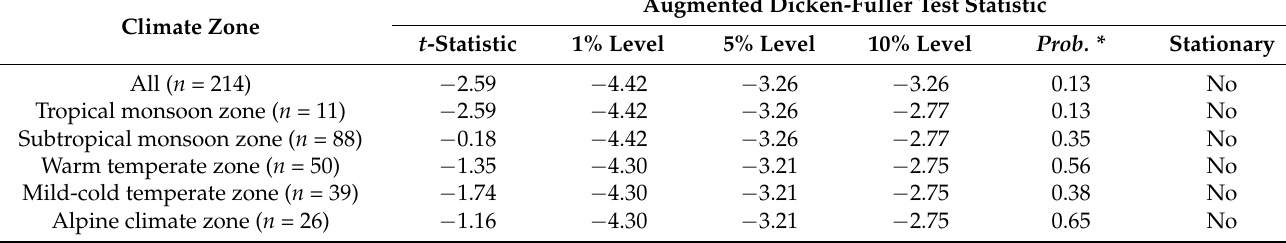
Table 4. Results of stationarity tests in